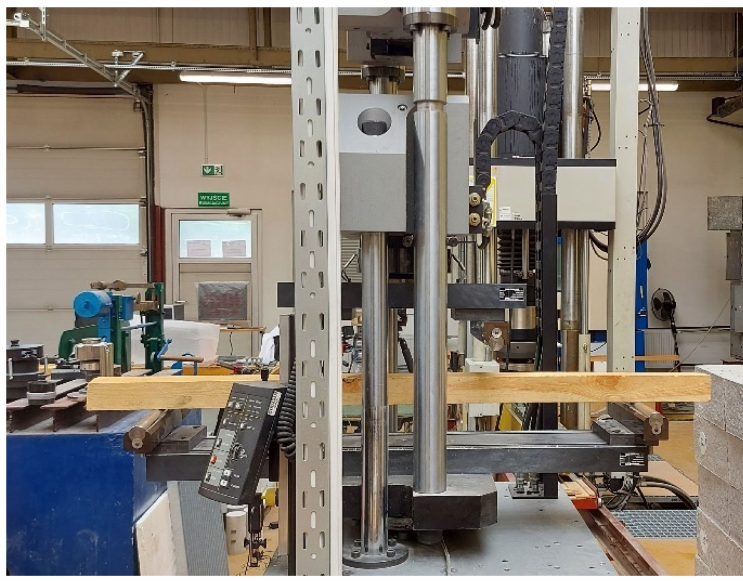
Figure 6. Bending strength test of the spruce wood element.